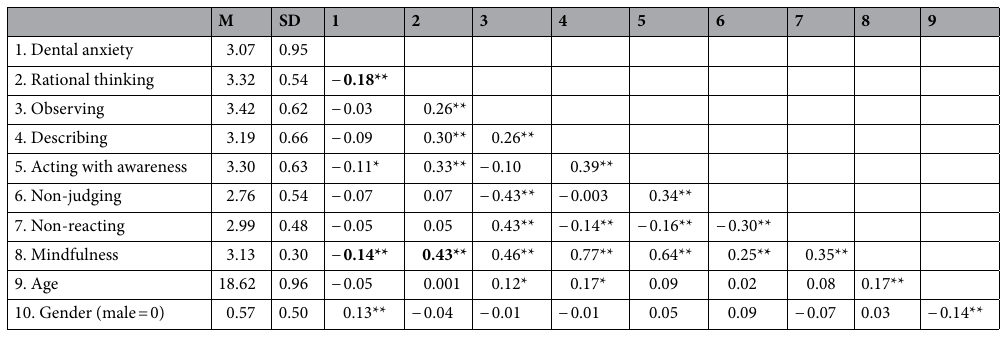
Table 3. Descriptive statistics and Correlations between primary variables (study 2). *p < 0.05, **p < 0.01, N = 394. Significant values are in